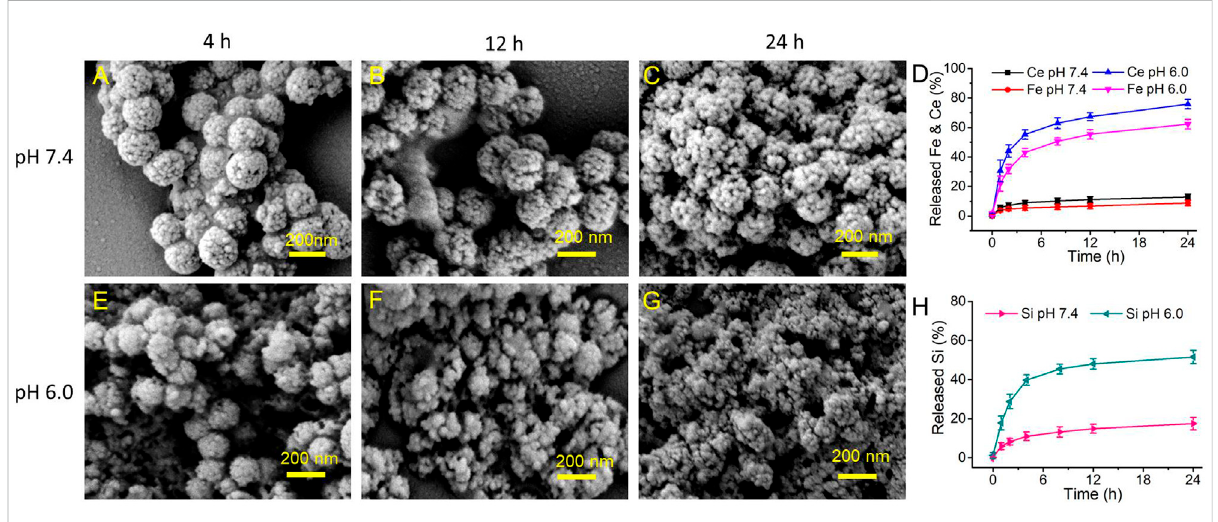
FIGURE 3 Decomposition ofFe/Ce-MSNNPs: (A – C) SEMimagesofFe/Ce-MSNNPs afterincubation inFBSsolutionatpH7.4 forvariousperiodsof time, and (E – G) SEMimages ofFe/Ce-MSNNPsafterincubationinFBSsolutionatpH6.0forvariousperiods oftime. (D,H) Accumulated releasing pro fi les of Ce, Fe and Si elements in FBS solution under at different pH (7.4 and 6.0).